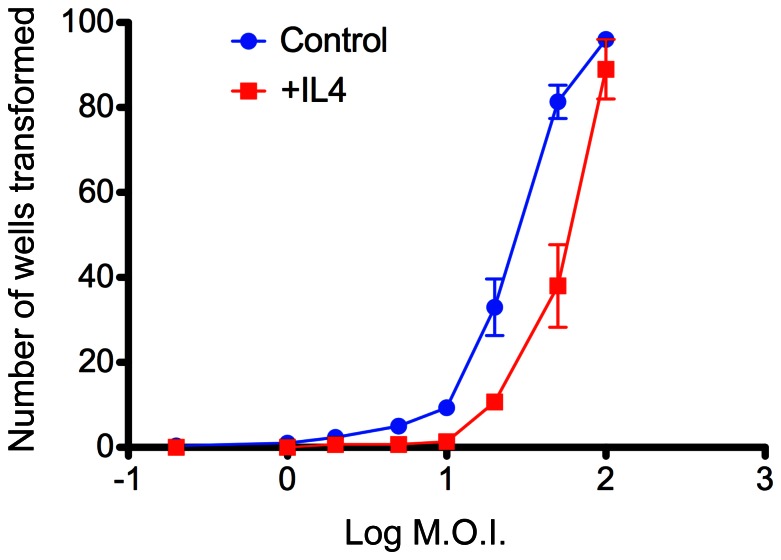
Effect of IL4 on EBV-induced B cell transformation.Purified B cells were infected with EBV at a series of multiplicities of infection (m.o.i.) in the absence or presence of added IL-4. For each infection dose, 103 B cells were seeded into each of the 96-wells of a microtest plate. The cultures were maintained in the presence or absence of IL-4 for 6 weeks, at which point the number of wells containing viable transformed colonies was counted. The data points and error bars represent the mean ± s.d for replicate experiments performed on B cells from three separate donors. Transformation efficiency, defined as the M.O.I. at which 50% of the cultures were transformed, was 23.8±3.2 for EBV alone and 56.5±10.2 for EBV plus IL-4.